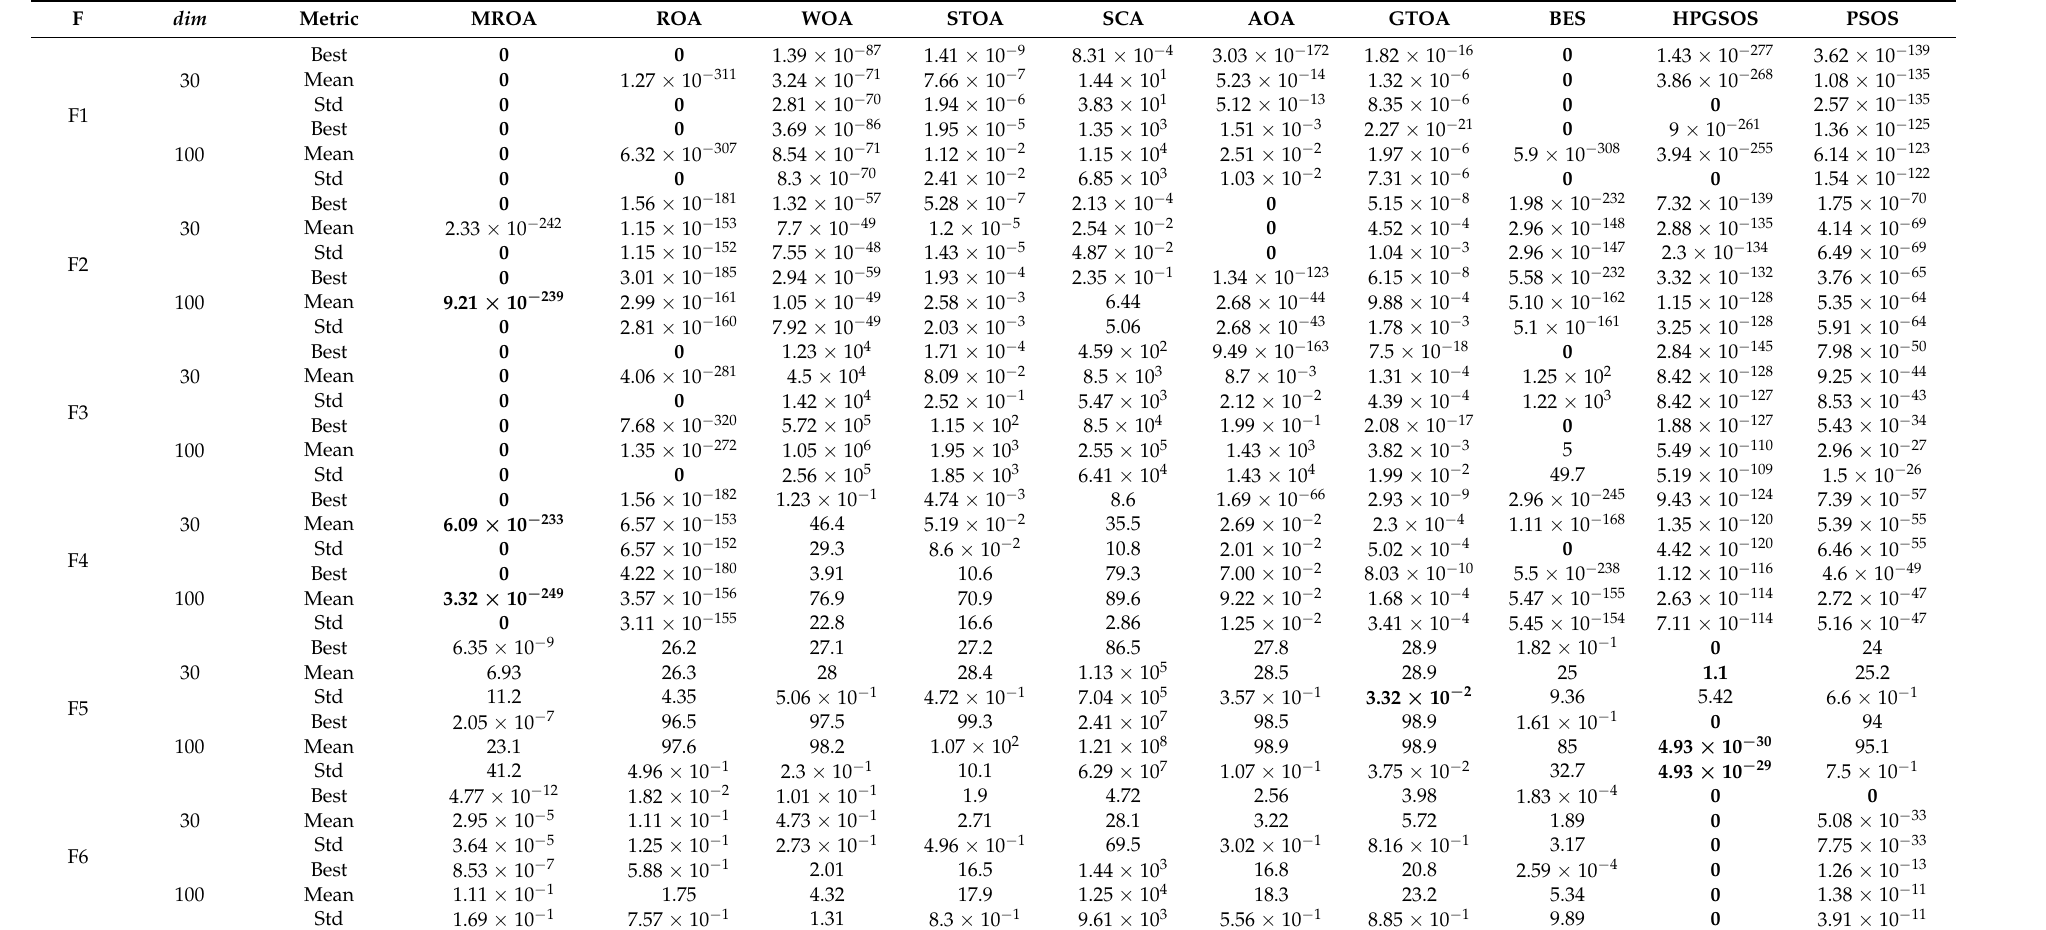
Table 3. Results of the MROA and other metaheuristic algorithms on test functions (F1–F23) in low dimensions (run 100 times). (Bold means good